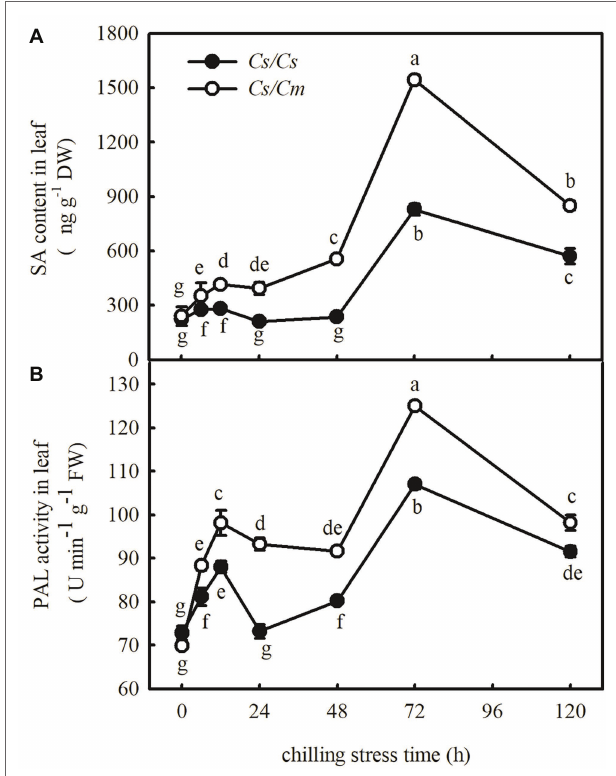
FIGURE 3 | Response of salicylic acid (SA) accumulation and phenylalanine ammonia-lyase (PAL) activities to chilling stress in Cs/Cs and Cs/Cm plants. (A) SA content and (B) PAL activity. Three-leaf stage seedlings were exposed to 5 ° C for 120 h and sampled at 0, 6, 12, 24, 48, 72, and 120 h. Data are the means of four replicates (±SDs). Different letters indicate a significant difference between samples according to Duncan’s new multiple range test ( p <